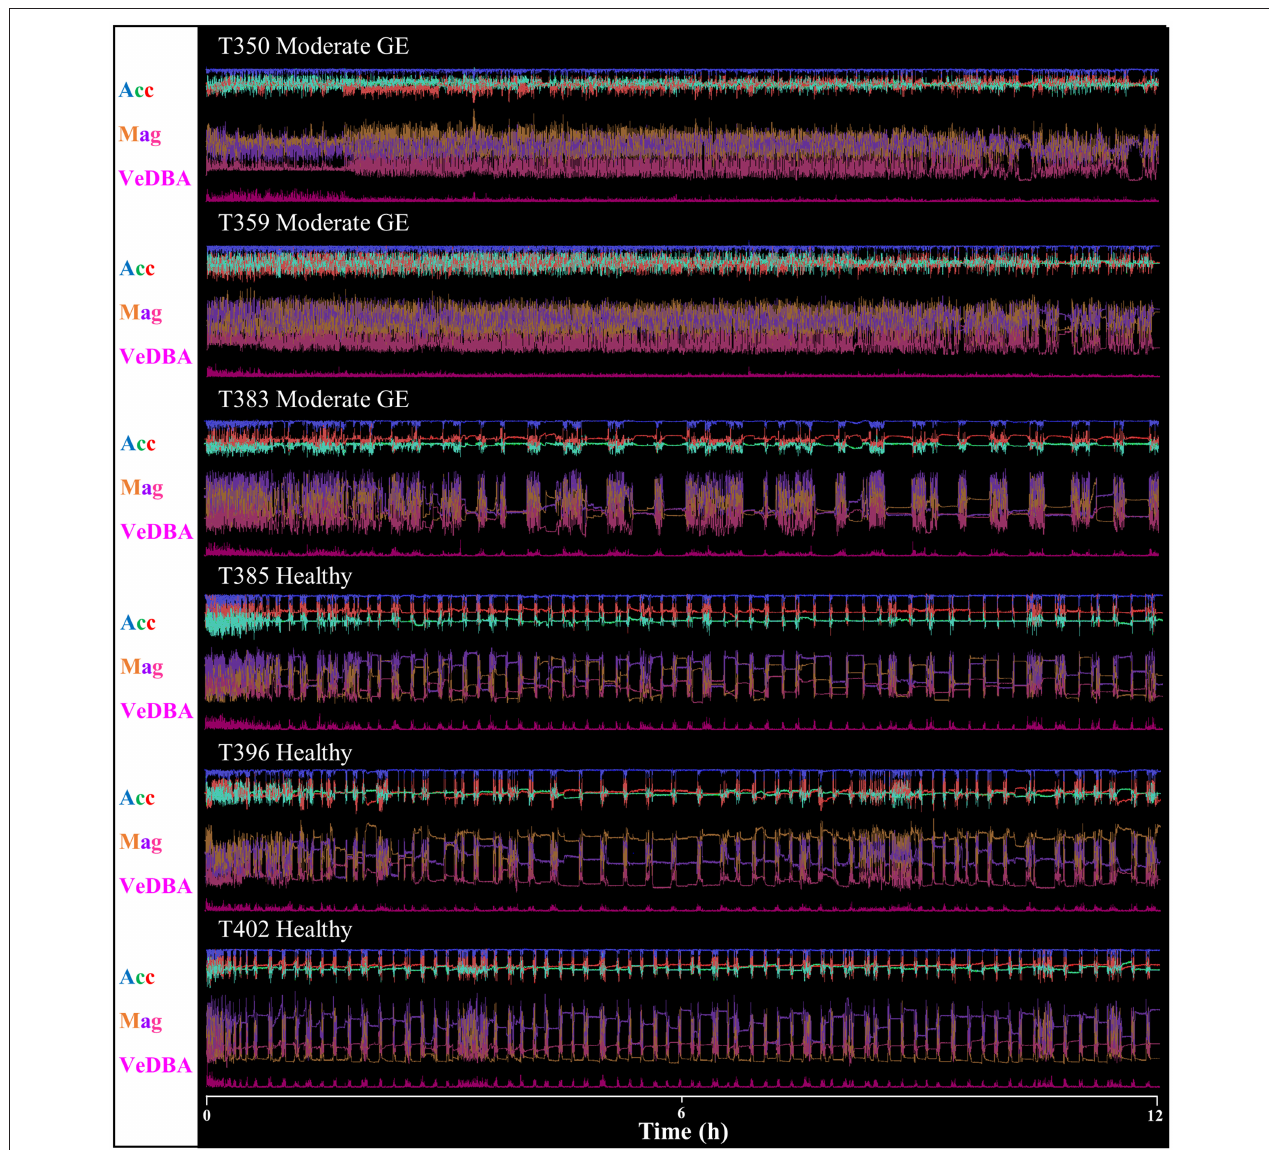
FIGURE 3 | Daily Diary recordings for five different individuals in various conditions showing the three orthogonal acceleration channels (Acc), three magnetometry channels (Mag) and a general activity metric (VeDBA—for definition see text). Scale is omitted to declutter graph; acceleration limits are − 1–1 g , magnetometry limits 0.2 − 0.8G). Data show 12h from the first time a turtle was tagged. Note how traces vary between individuals that are healthy and those with gas emboli (GE); the former tended to display regular, alternating rest and dive periods, exhibited by the magnetic field data, and the latter exhibited increased activity lasting 3h or